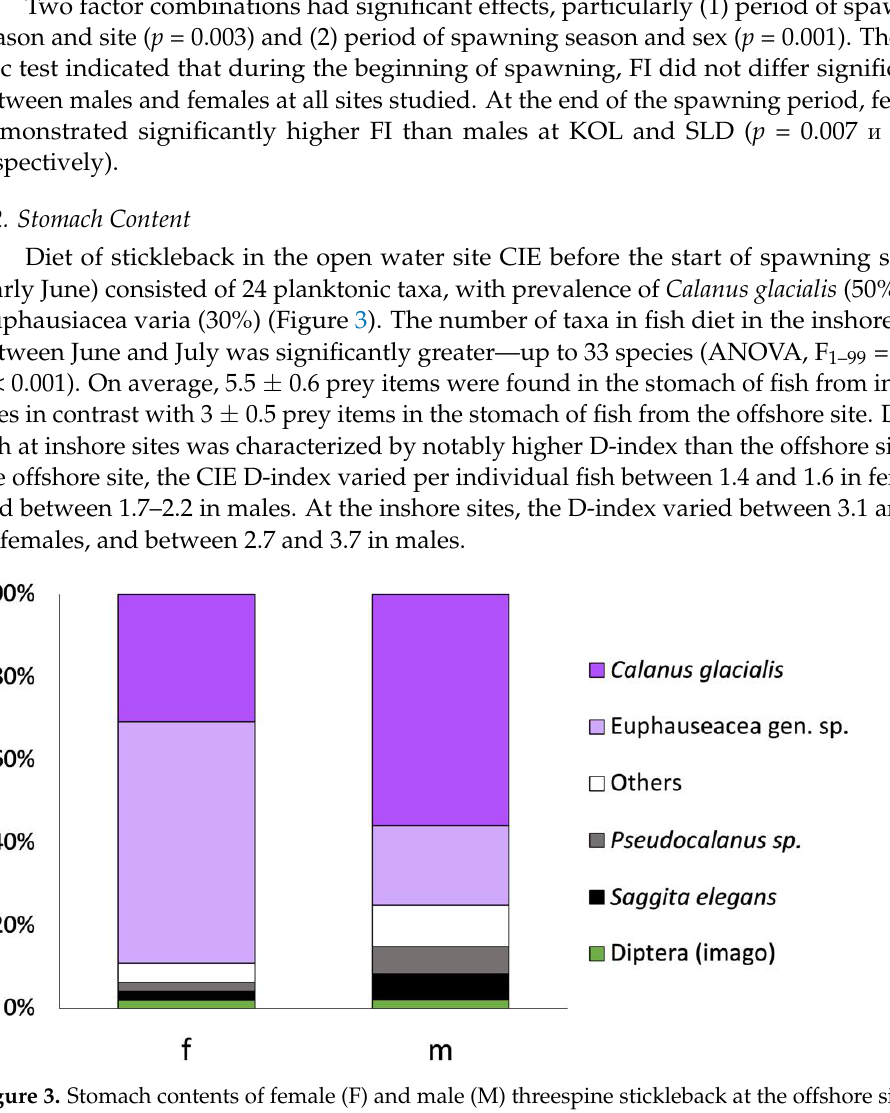
Figure 2. Feeding intensity of threespine stickleback during the spawning season. The Y-axis repre- sents stomach fullness index FI ( ‱ ). The dots and bars represent the sample means and standard errors (SE).